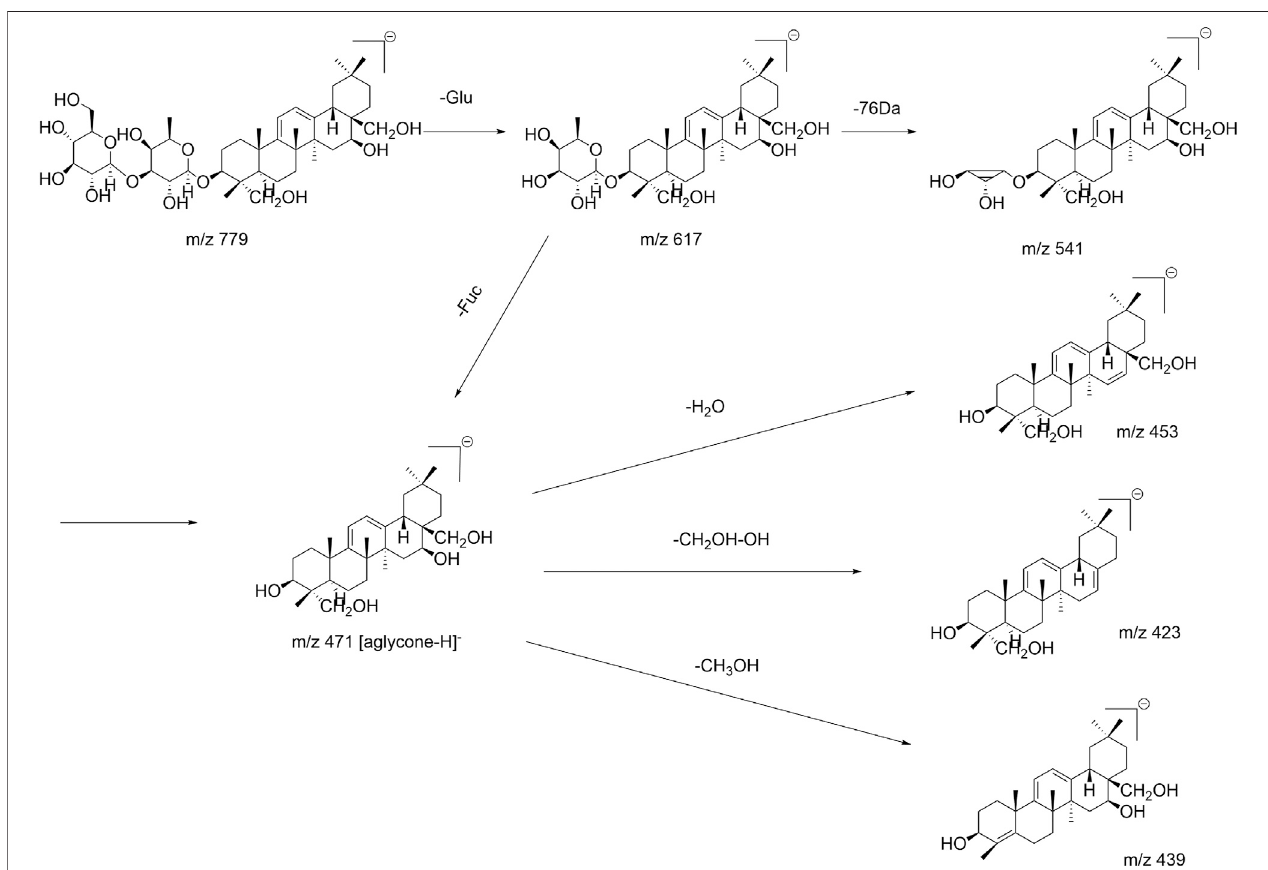
FIGURE 6 | Fragmentation pathway of